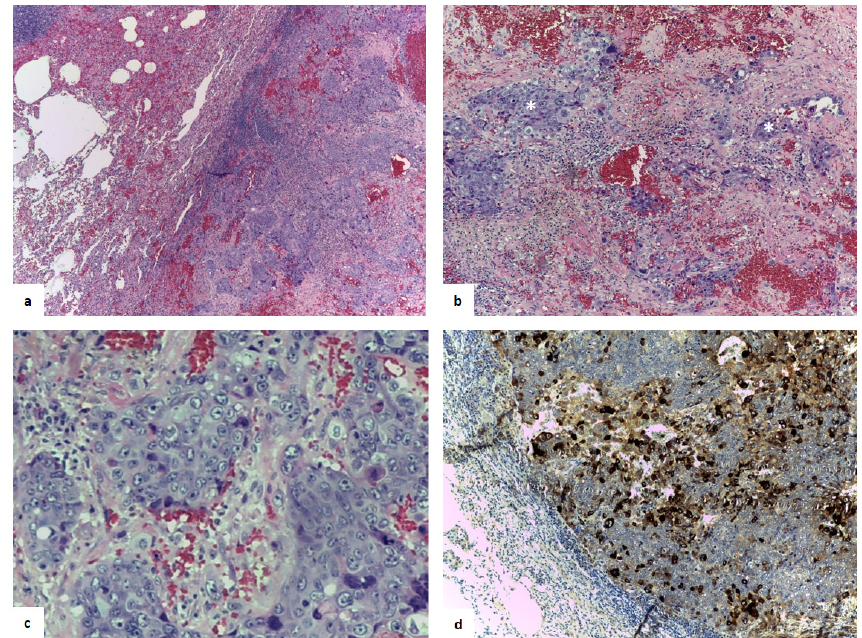
Figure 4. ( a ) Hematoxylin (blue staining of the nuclei) and eosin (pink staining of cytoplasm and extracellular matrix) mark showed a highly hemorrhagic tumor. ( b ) An intimate admixture of atypical cytotrophoblasts and syncytiotrophoblasts arranged in nests without a villus structure (enlighten with asterisks), magnified in ( c ). ( d ) The immunohistological findings indicated that the tumor cells were strongly positive (brown) for human chorionic gonadotropin (magnification in a: 10×, b,c, and d: